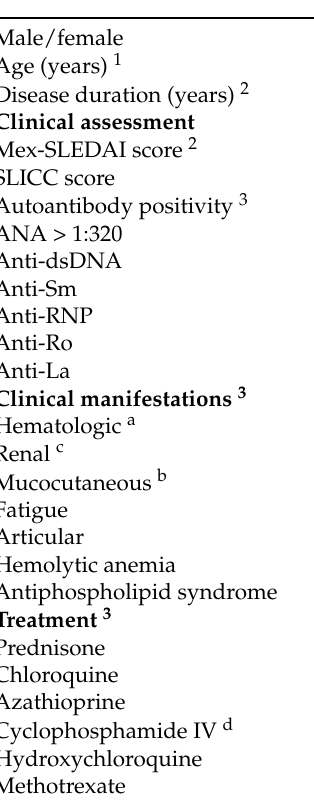
Table 1. Demographic and clinical characteristics of SLE patients ( n =